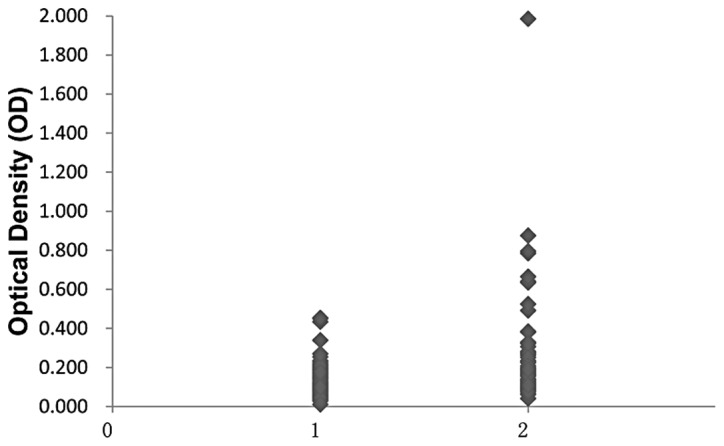
Titer of the autoantibody to Prdx1 in ESCC and normal human sera (NHS). The range of antibody titers to Prdx1 is expressed as the optical density (OD) obtained from ELISA. The y-axis represents the OD values; the x-axis represents serum samples: 1, NHS; 2, ESCC sera. The titer of anti-Prdx1 in ESCC was much higher than that in the NHS (P<0.01). Prdx1, peroxiredoxin 1; ESCC, esophageal squamous cell carcinoma.